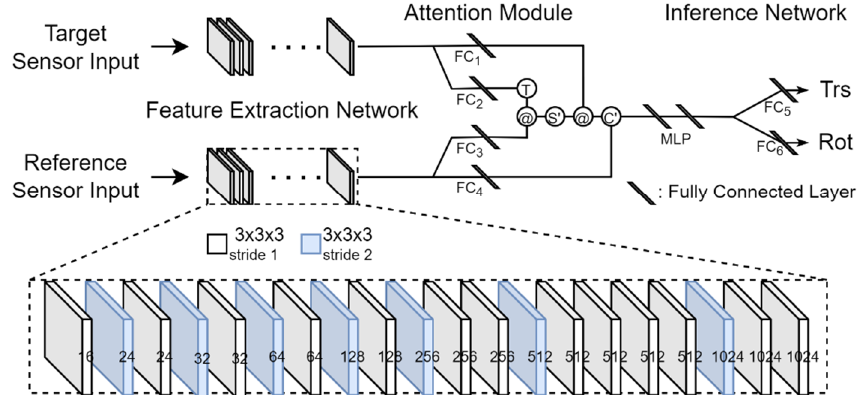
Figure 1. Overall structure of the proposed network. In the attention module, the T within a circle represents the transpose of a matrix; @ within a circle represents a matrix multiplication; S’ within a circle represents the soft max function; C’ within a circle represents concatenation. In the inference network, Trs and Rot represent the translation and rotation parameters predicted by the network, respectively.